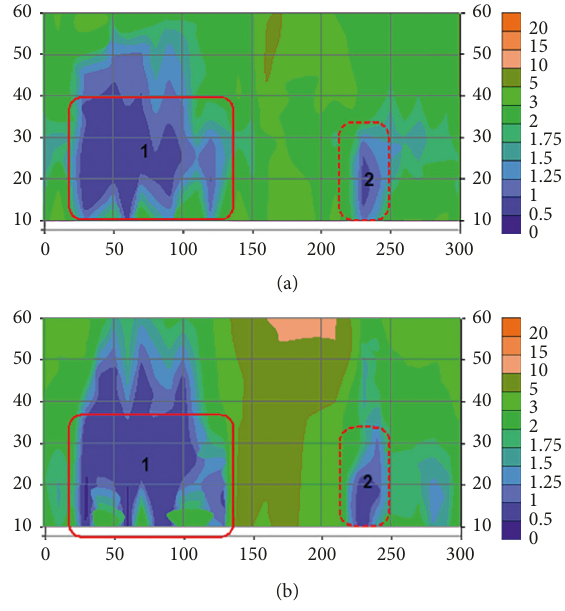
Figure 2: Apparent resistivity detected by the transient electro- magnetic method in 15107: (a) apparent resistivity detected in vertical direction and (b) apparent resistivity detected 45 ° with the angle of the